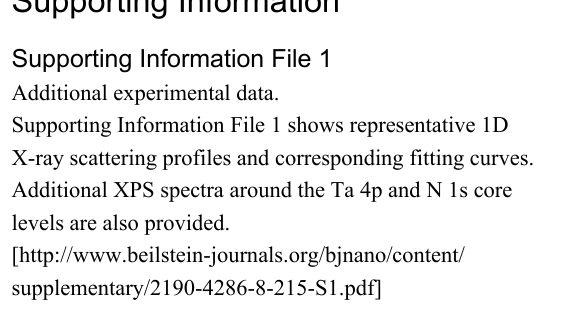
Figure 6: Depth distribution of chemical bonds in the ML12m9 sample obtained from XPS spectra acquired for different Ar + sputtering times.